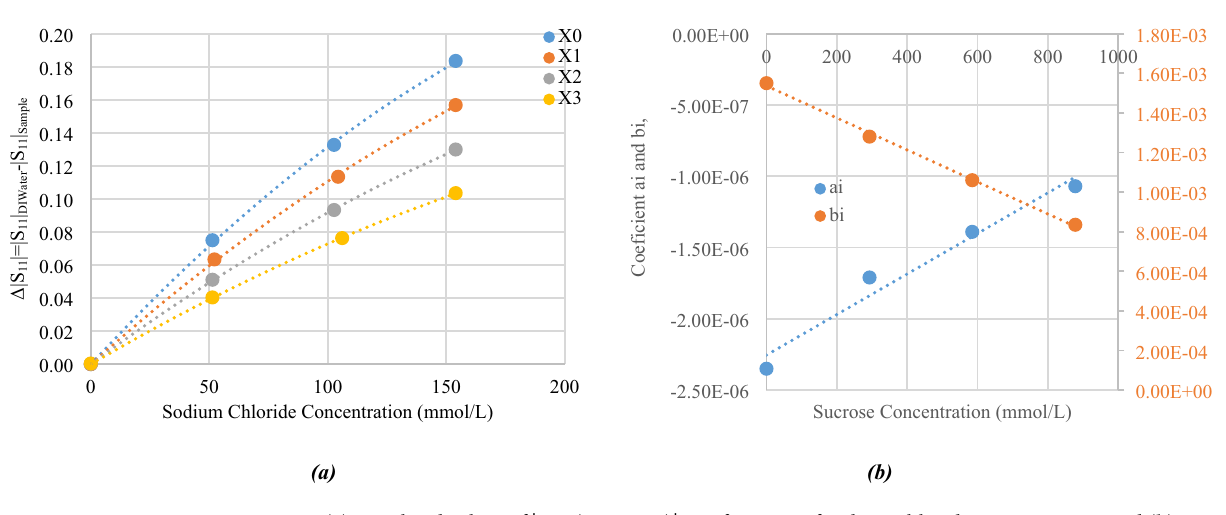
Figure 15. ( a ) Simulated values of |S11 (100 MHz)| as a function of sodium chloride concentration, and ( b ) values of the coefficients a i and b i of the polynomial approximation as a function of sucrose